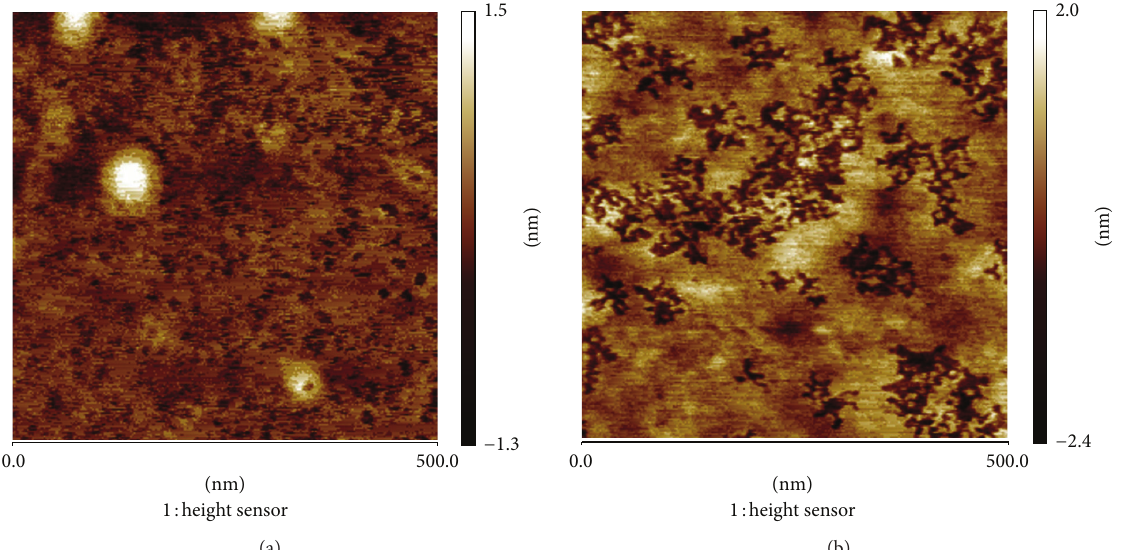
Figure 5: AFM images of foamed gel samples in the scanning range of 500 nm. (a) Polymer H; (b) polymers H and AL blends.